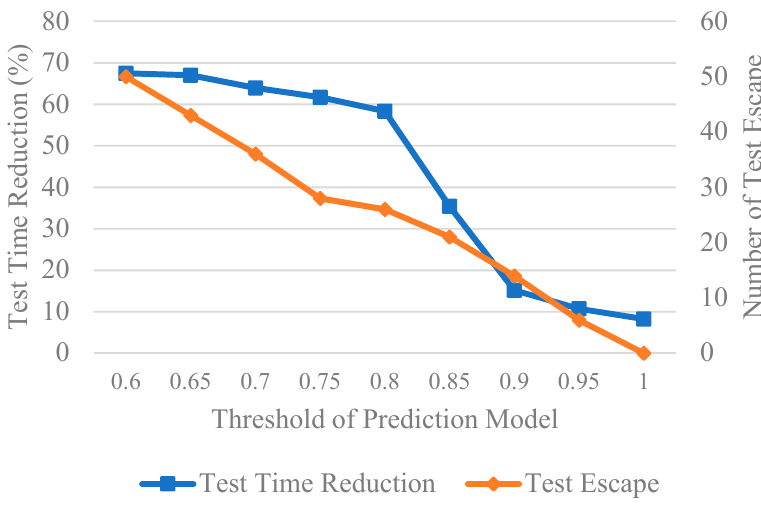
Figure 4. The results of different threshold